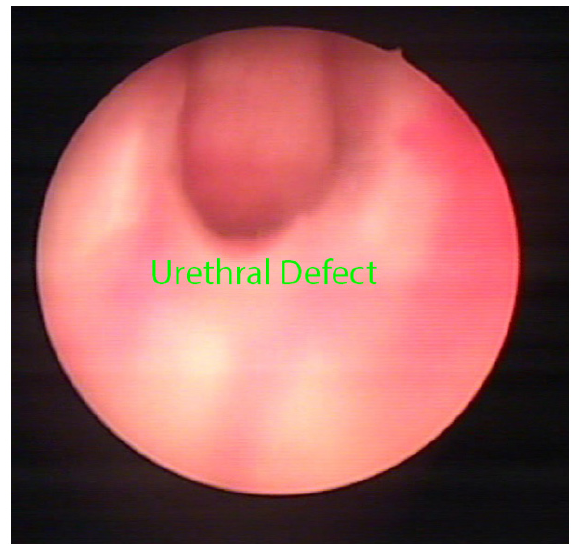
Figure 1. Cystouethroscopy showing urethral defect.